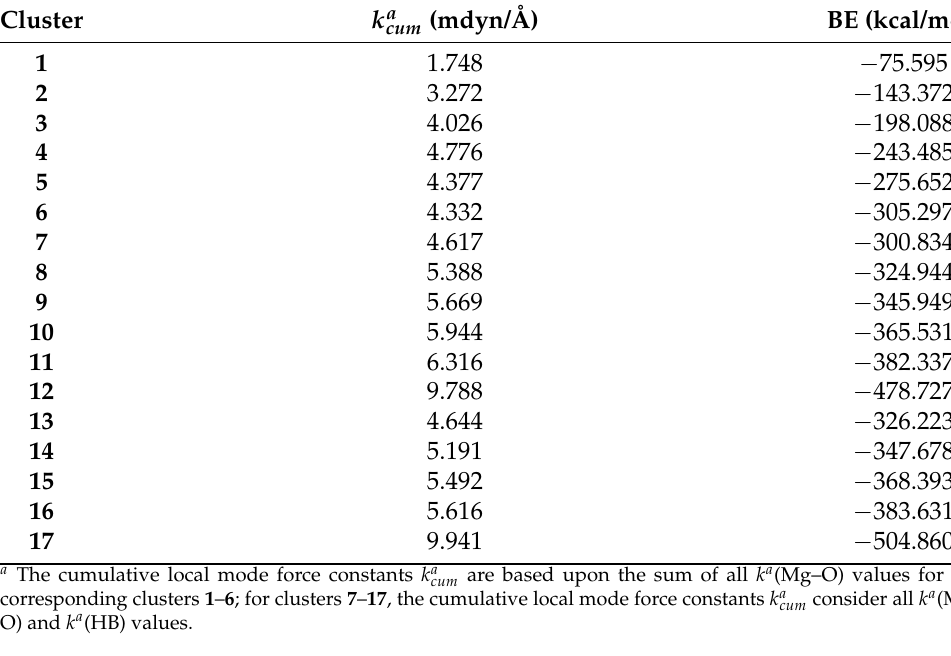
Table 3. The cumulative local mode force constants k a cum and binding energies (BE) for clusters 1 – 17 at the ω B97X-D/6-311++G(d,p) level of theory.